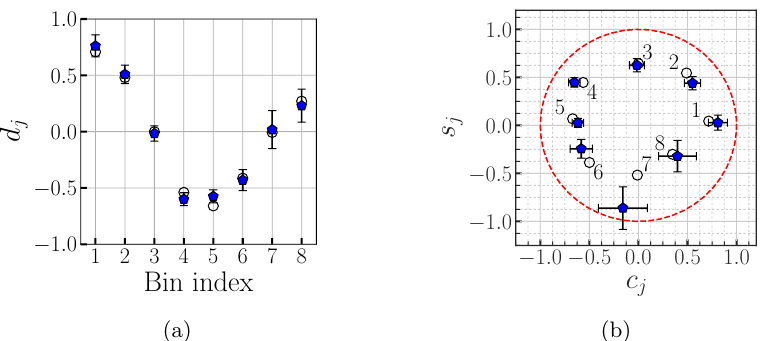
Figure 4 . Results of MC simulation: dilution factors d j (a) and phase parameters c j and s j (b). Empty circles show the input values, blue pentagons with error bars show the (cid:12)t results obtained for the expected Belle II statistics and experimental